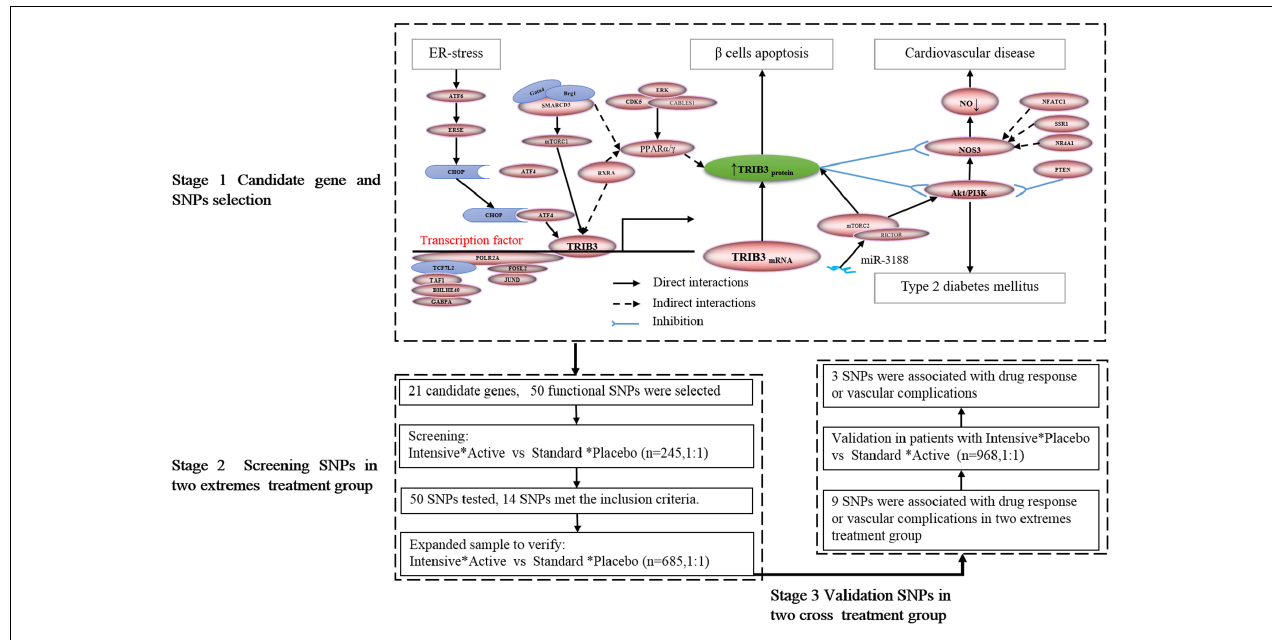
FIGURE 1 | Candidate biomarker selection and pipeline of study